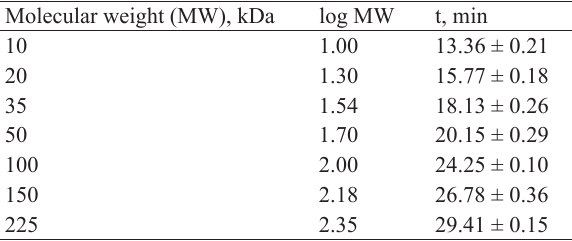
Table 1 Migration time of proteins with known molecular weight separated by capillary gel